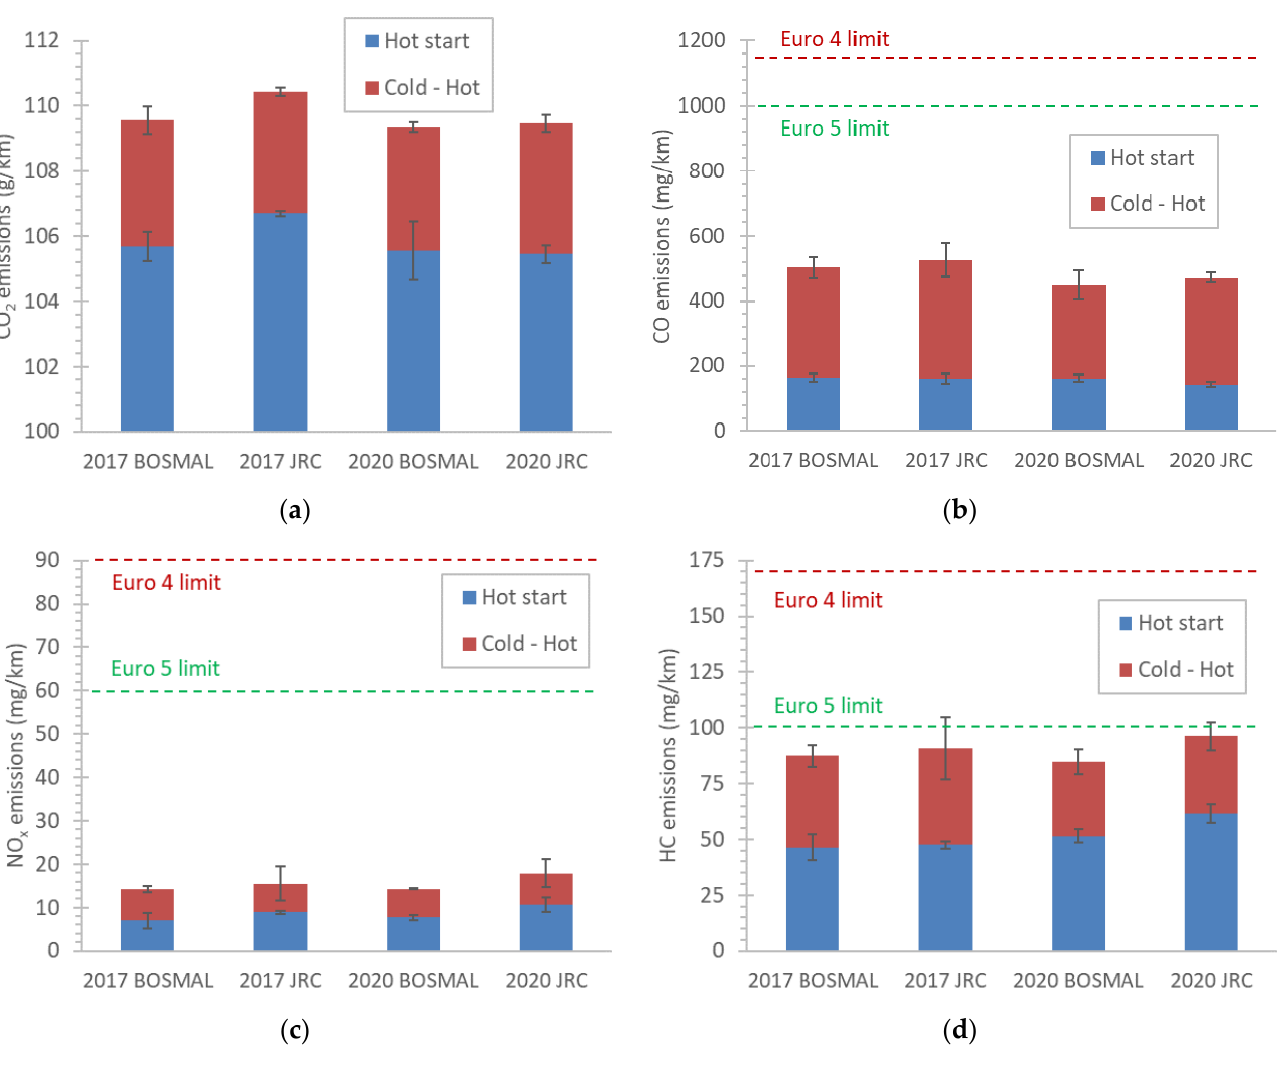
Figure 2. Emissions of gaseous pollutants at the two laboratories (BOSMAL, JRC) at the two campaigns in 2017 and 2020 for cold start and hot start cycles: ( a ) CO 2 ; ( b ) CO; ( c ) NO x ; ( d ) HC (hydrocarbons). Dashed red lines show the Euro 4 limits applicable to this motorcycle, and green dashed lines the Euro 5.